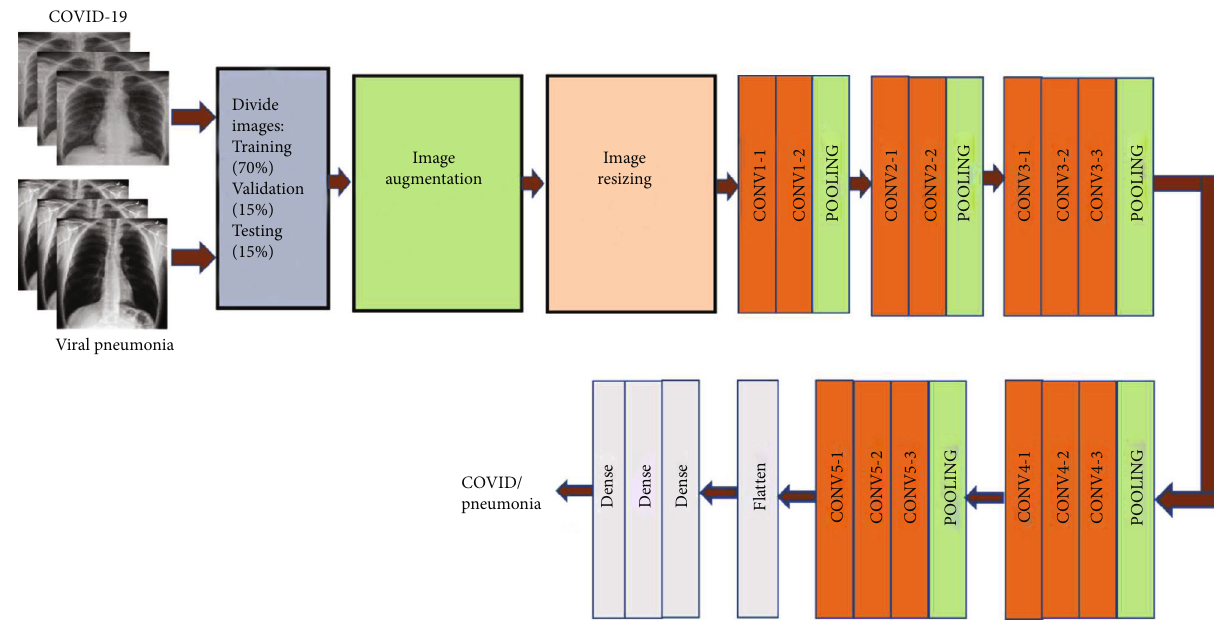
Figure 2: The con fi guration of the VGG16-based